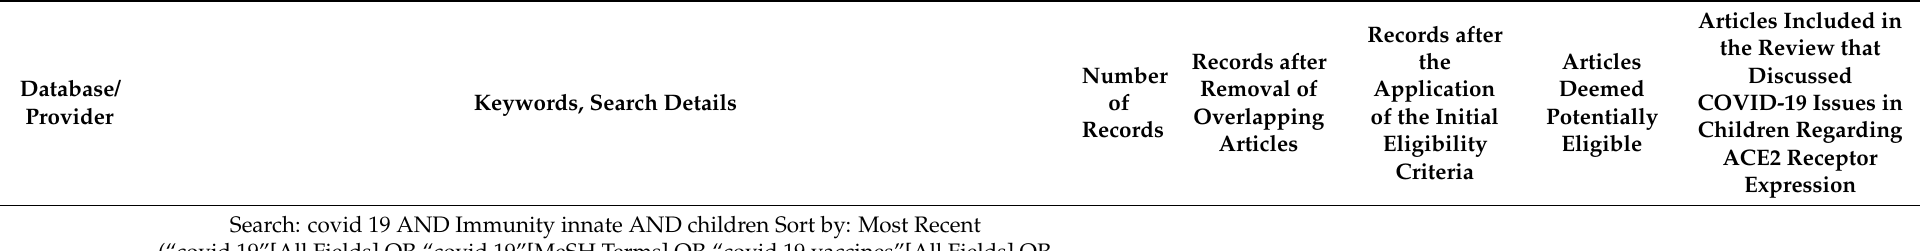
Table 2. Complete overview of the search methodology. Overlaps were removed using EndNote X8. Records identified by databases: 857; records selected for qualitative analysis: 18.